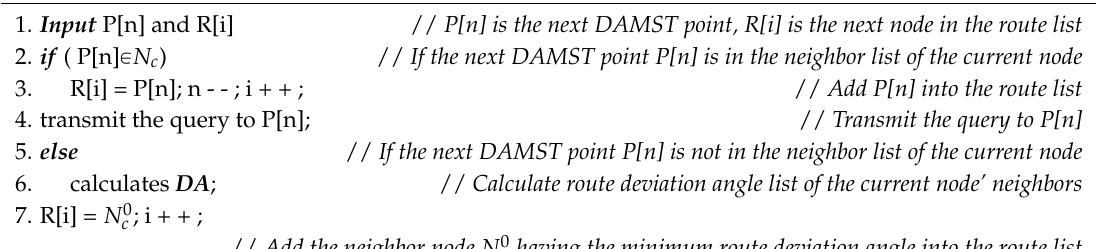
Algorithm 2. The routing algorithm based on route deviation angles.